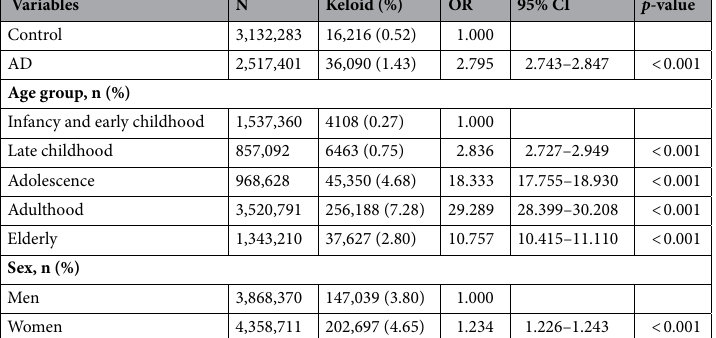
Table 2. Prevalence of keloids in patients with and without AD. The effect of presence or absence of AD on the risk of keloids was evaluated using the simple logistic regression. AD atopic dermatitis, CI confidence interval.